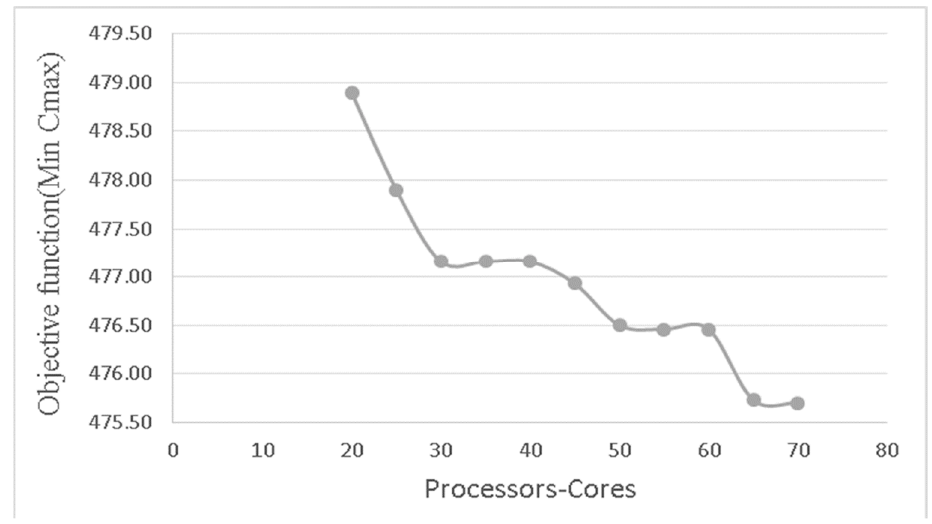
Figure 9. HGAG behavior using different population sizes.